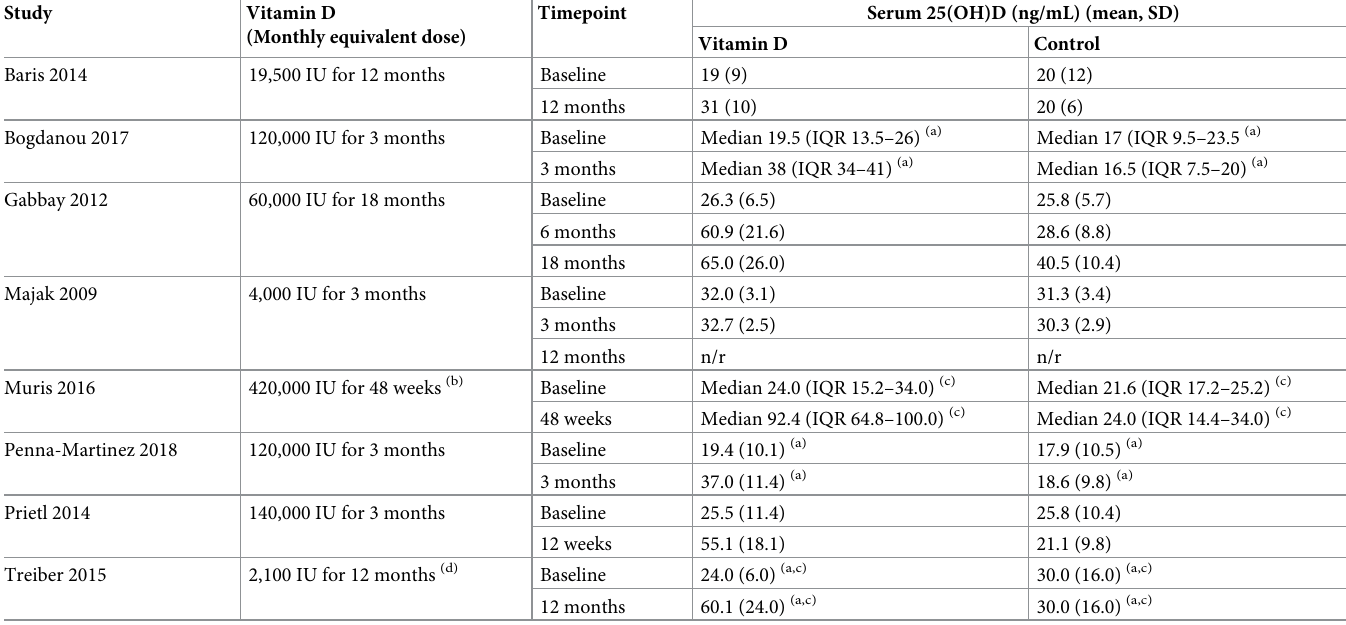
Table 2. Serum 25(OH)D